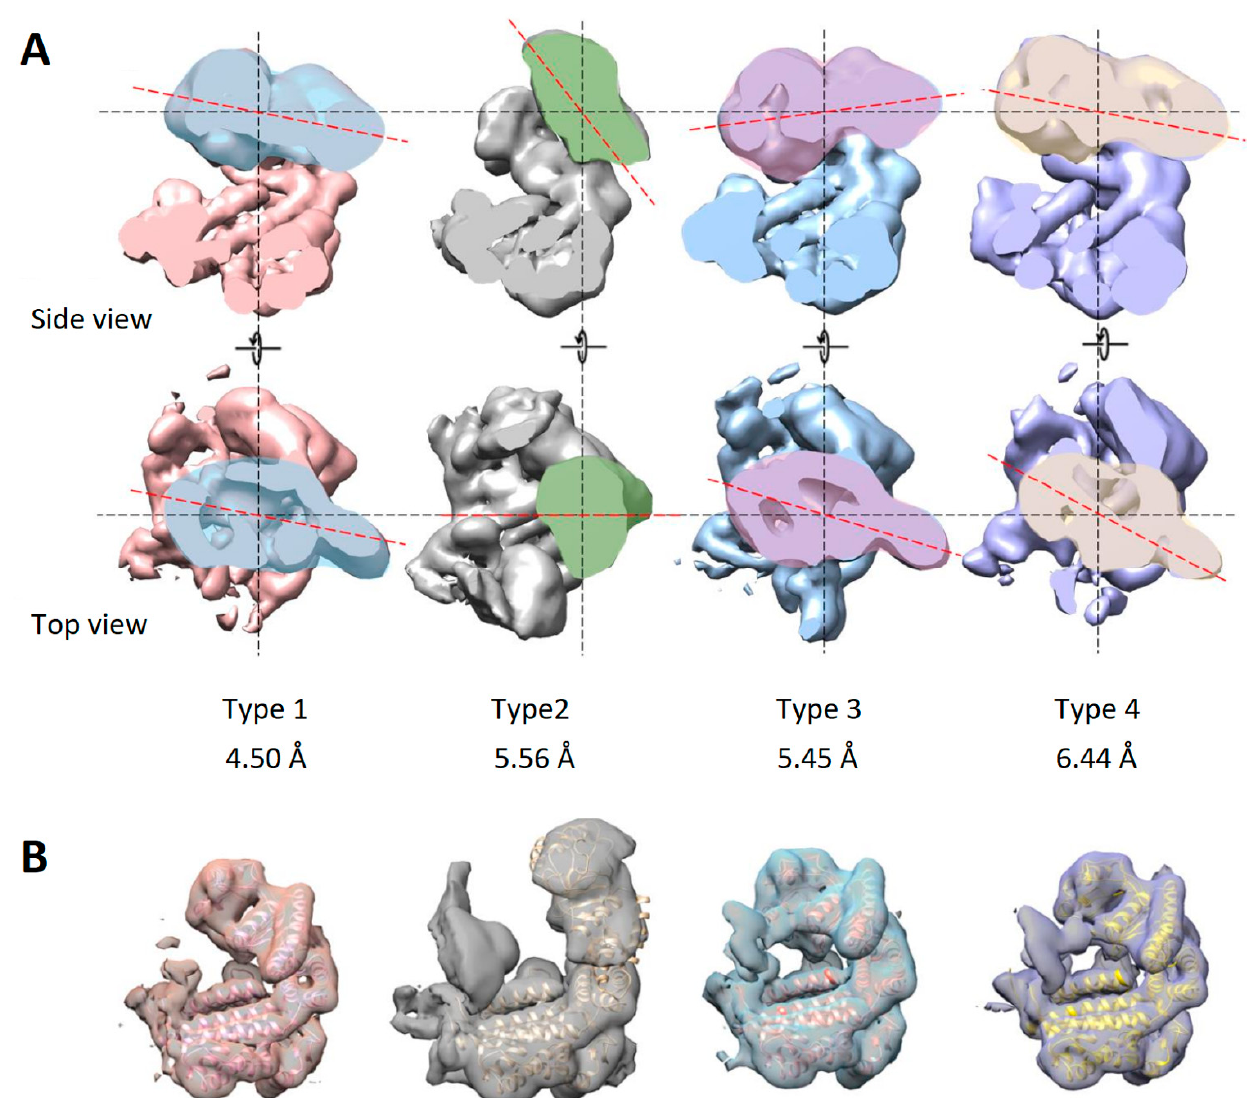
Figure 4. Conformational variability the apo-form of the AR9 chaperonin. ( A ) Subunit conformations resolved at 4.50 Å, 5.56 Å, 5.45 Å and 6.44 Å. The red dotted line indicates the orientation of the apical domain. ( B ) Fitting of atomic models into density maps of identified subunit confor- mations.